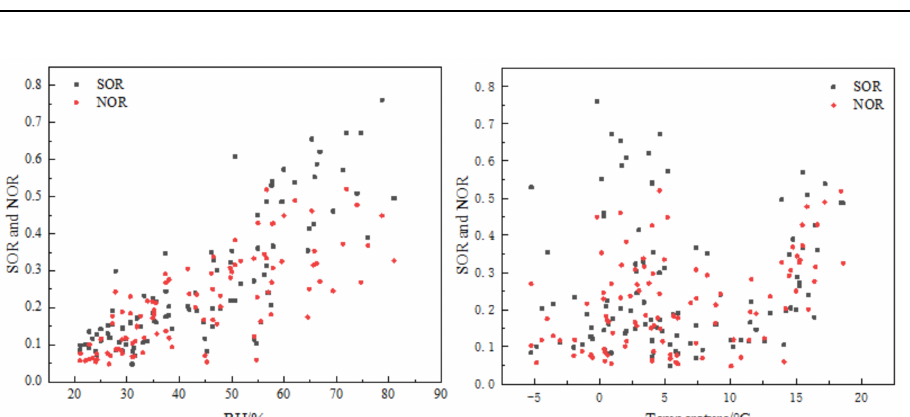
Figure 4. Correlation between temperature and relative humility with